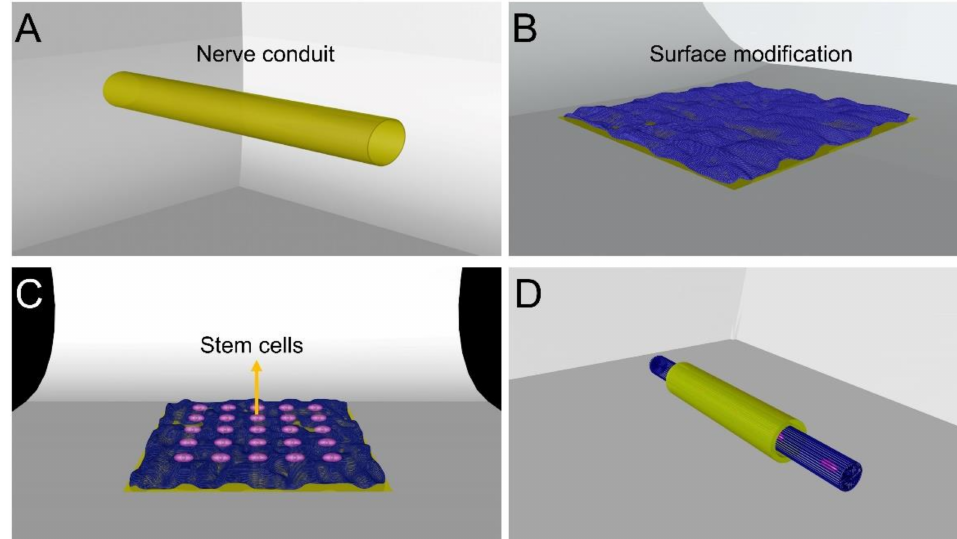
Figure 2. ( A ) Common nerve conduit model surface. ( B ) Use of specific surface modification, to change the roughness of the surface or the three-dimensional surface area. ( C ) This surface-modified nerve conduit material can promote cell attachment and proliferation. ( D ) Nerve catheter made of cells that promote peripheral nerve regeneration such as Schwann